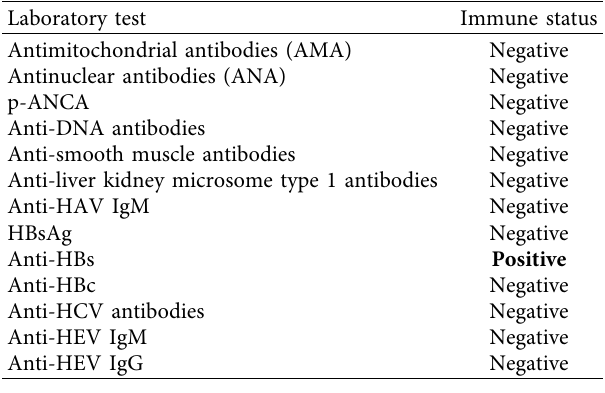
Table 2: Autoimmune and hepatitis